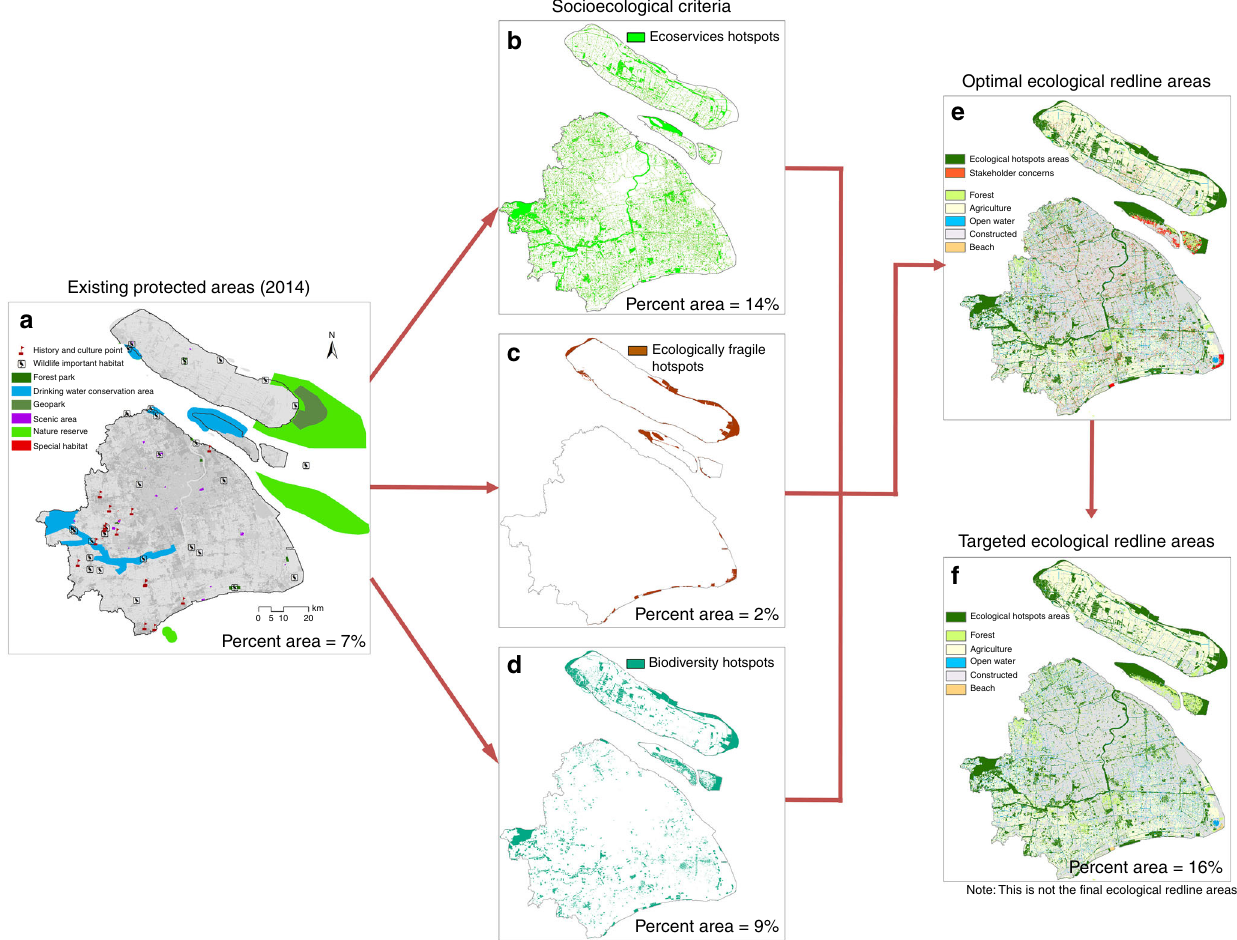
Fig. 3 Spatial results for each step of the spatial planning process to select the ecological redline areas for Shanghai Municipality. a Existing protected areas for 2014, small patches with limited connectivity, representing only 7% of Shanghai ’ s land area. We used the Ministry of Environmental Protection criteria to formulate three indicators for determining optimal ERAs: b ecosystem services hotspots; c ecologically fragile hotspots; and d biodiversity hotspots. Next optimal ERAs (determined from socioecological criteria) were presented to stakeholders who re fi ned ERAs. e Stakeholders indicated areas of concern meaning areas they felt were not manageable (i.e., removal of small patches) or pose serious social and economic burdens to communities (i.e., removal of major disagreement areas). f Targeted ERAs are not the fi nal ERAs but Shanghai Municipality is considering using them to form the fi nal ERAs. The maps